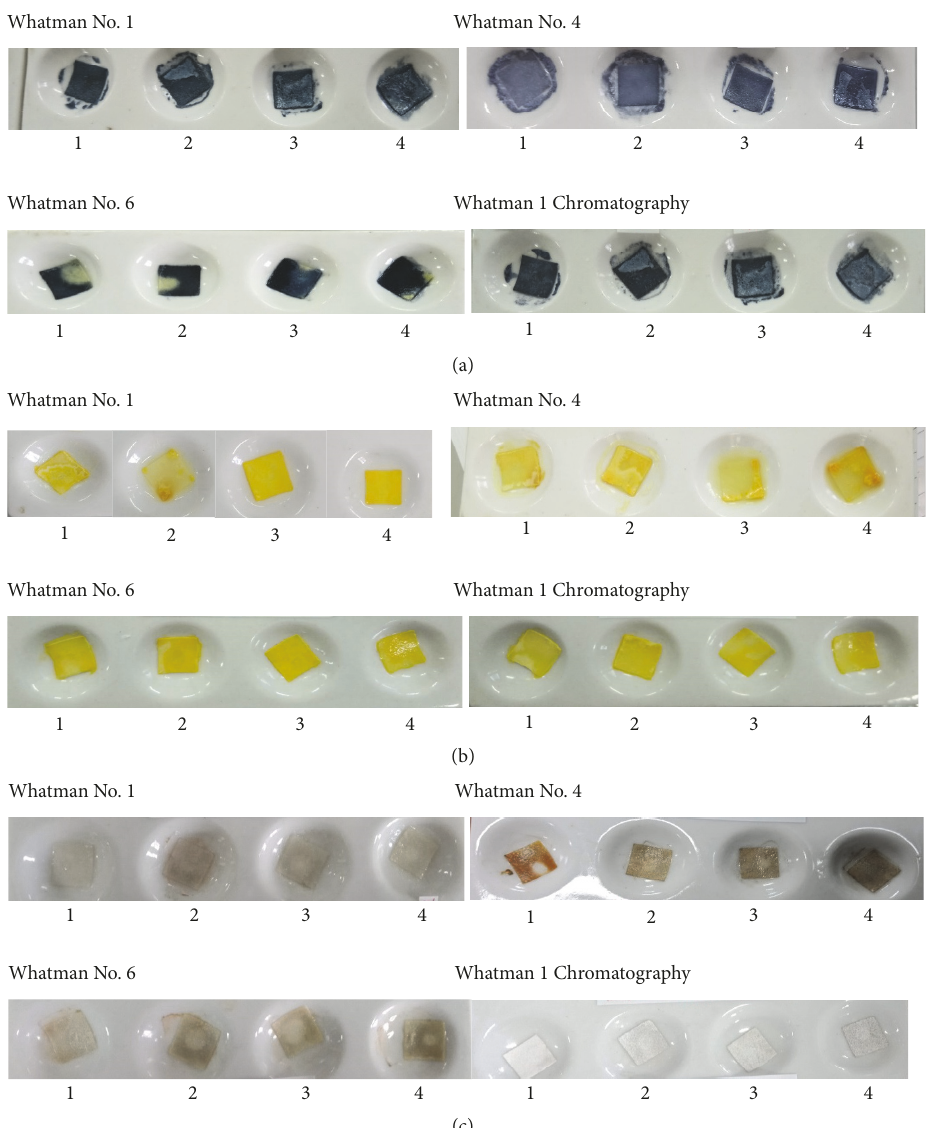
Figure 3: Color change of Whatman filter paper in the presence of allopurinol in a variation of immersion time: (1) 10 min; (2) 20 min; (3) 40 min; (4) 60 min. (a) Folin-Ciocalteu reagent + allopurinol; (b) p-DAB reagent + allopurinol; (c) Tollens reagent +